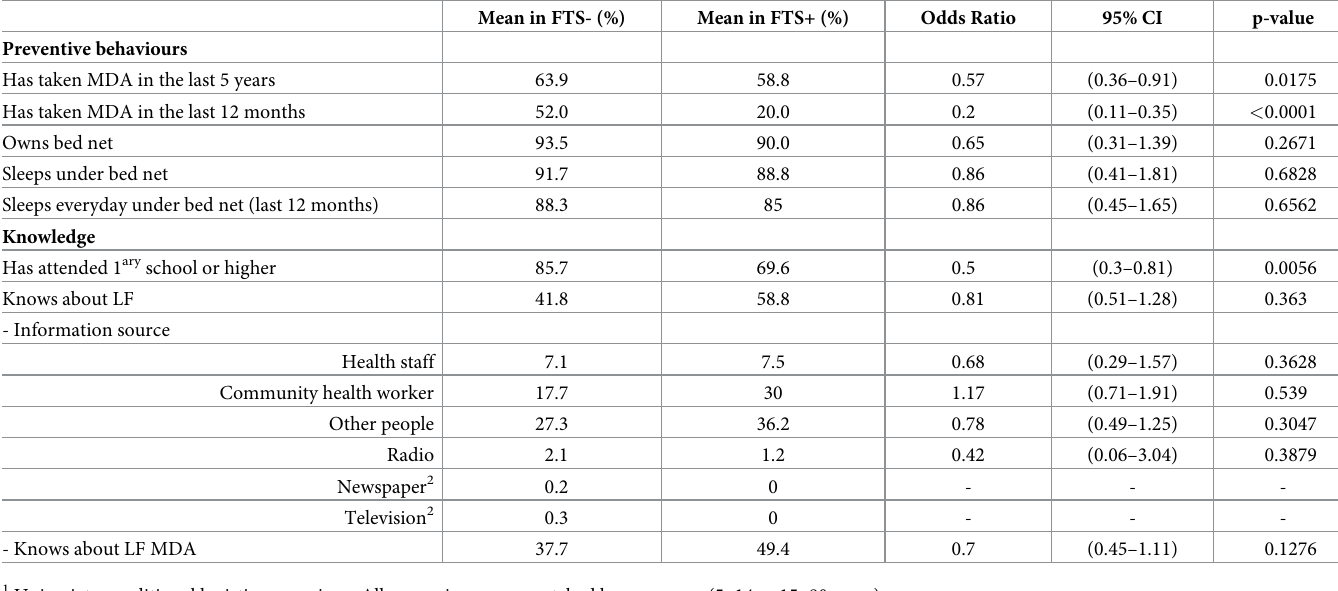
Table 5. Factors associated with FTS positivity in sentinel and spot-check sites of Manakara, Mananjary, Vohipeno and Ifanadiana 1 (N =